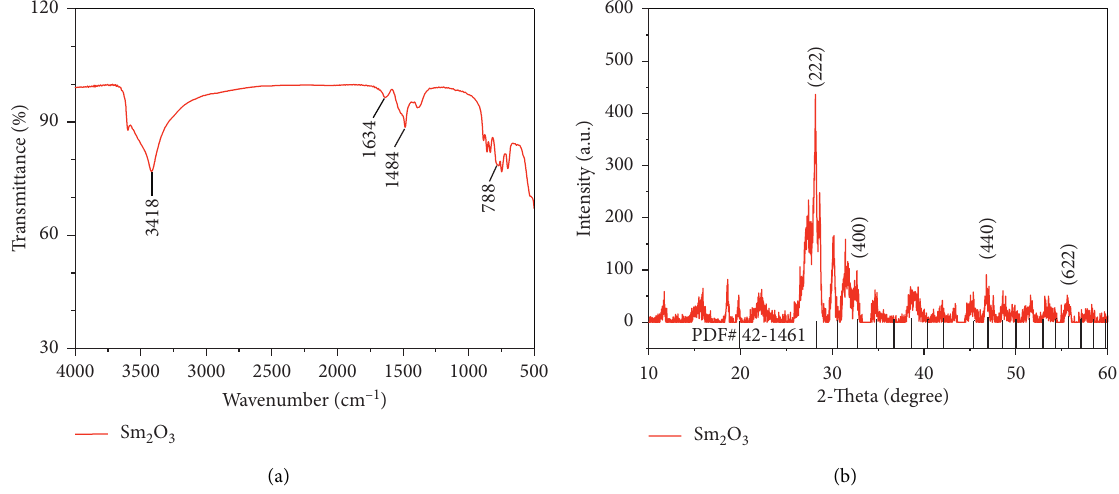
Figure 3: (a) FT-IR spectrum of nano-Sm